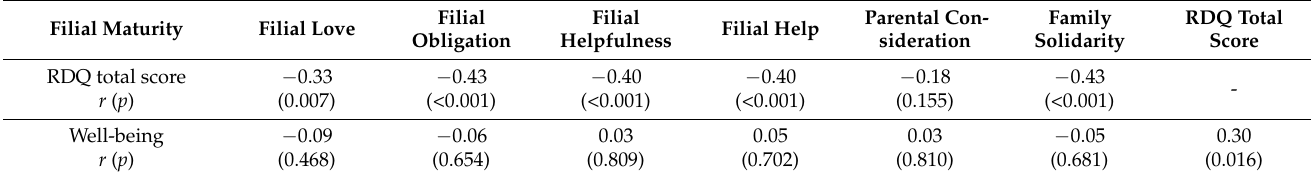
Filial Maturity Filial Love